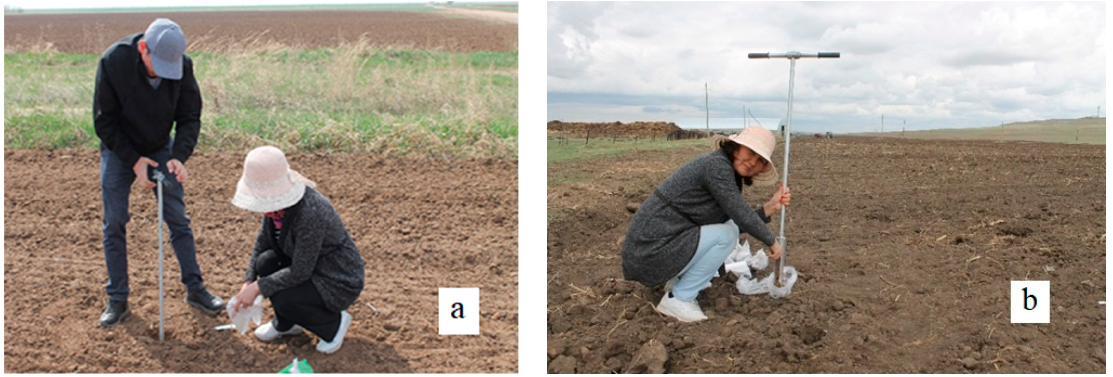
Figure 2. Manual soil sampling from a grain field. ( a ) In the spring before fertilizing. ( b ) Autumn after